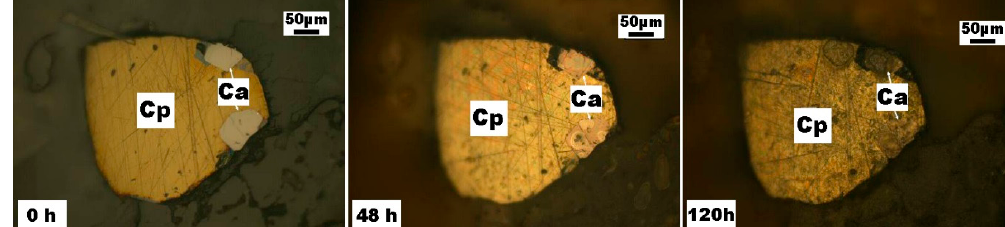
Figure 2. Microscopic characteristics of bio-oxidating chalcopyrite (Cp)/carrollite (Ca) mineral pair.